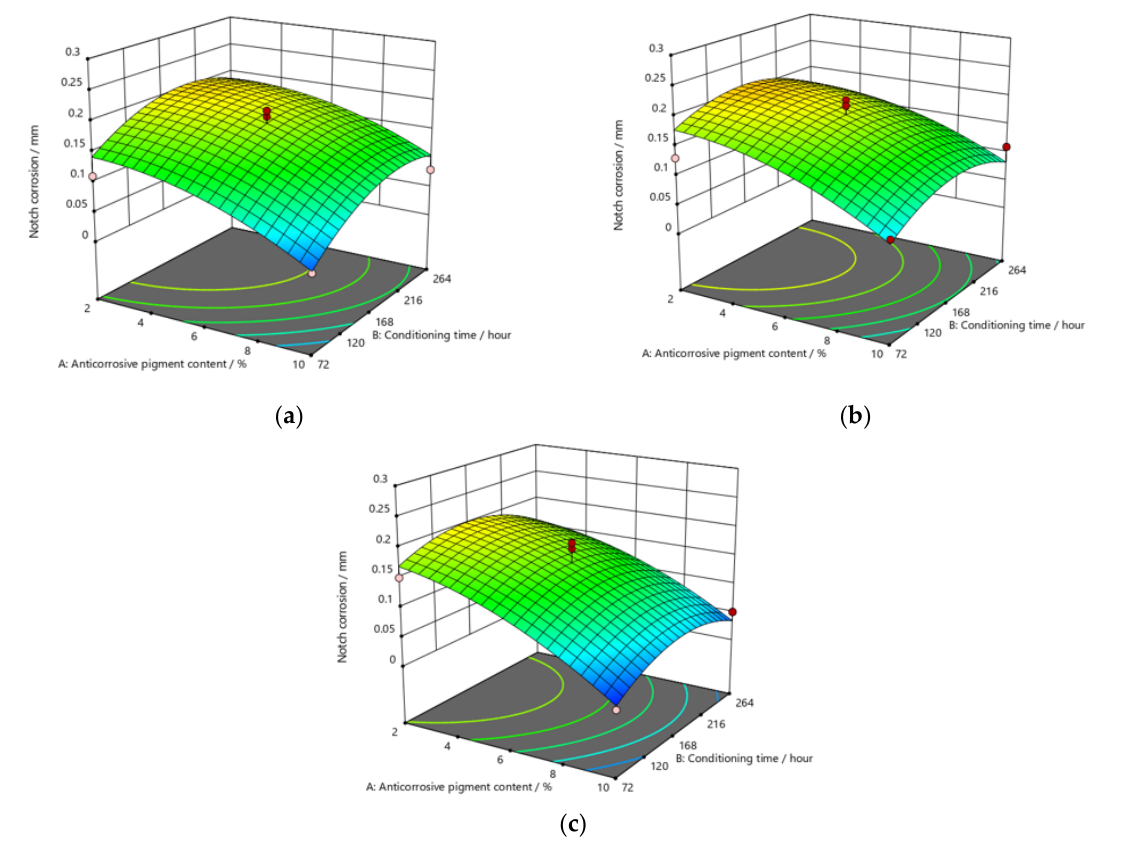
Figure 9. Response surface for regression model of notch corrosion for coating thickness of ( a ) D 1,